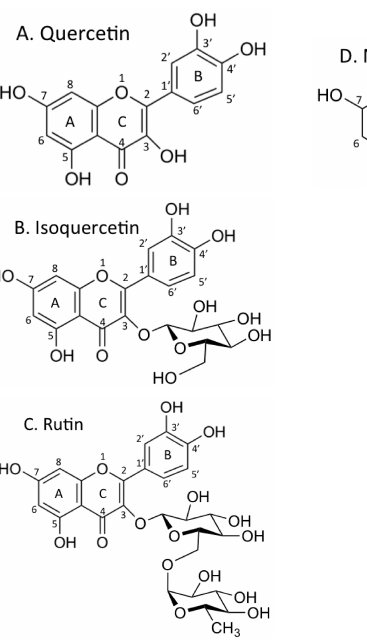
Figure 1. Chemical structures of flavonoids. A. quercetin, B. isoquercetin, C. rutin, D. naringenin, E. naringin, F. hesperetin, G. hesperidin.